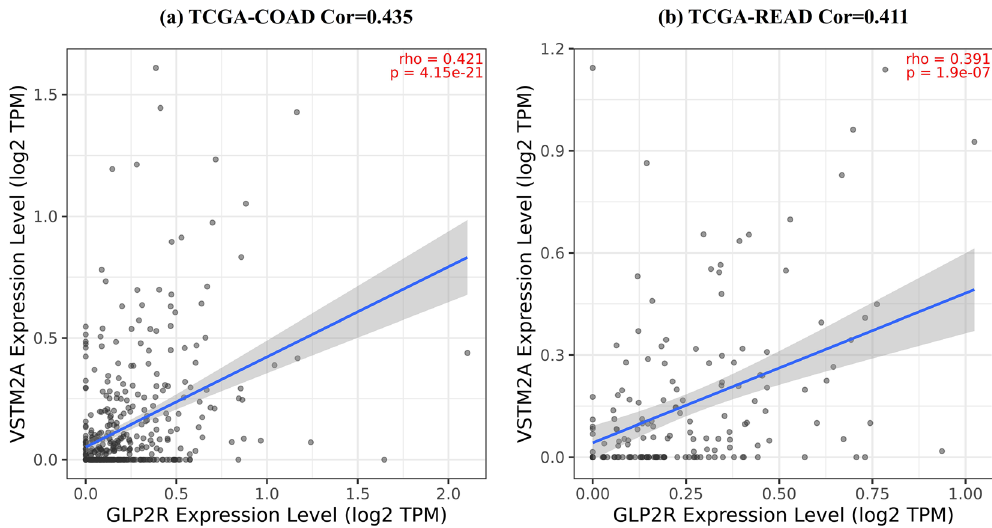
Figure 7. Correlation analysis of GLP2R and VSTM2A for TCGA-COAD and TCGA-READ samples. It shows strong positive and statistically significant correlation between both TCGA datasets. ( a ) Correlation value of 0.435 for TCGA-COAD samples, and ( b ) Correlation value of 0.411 for TCGA-READ